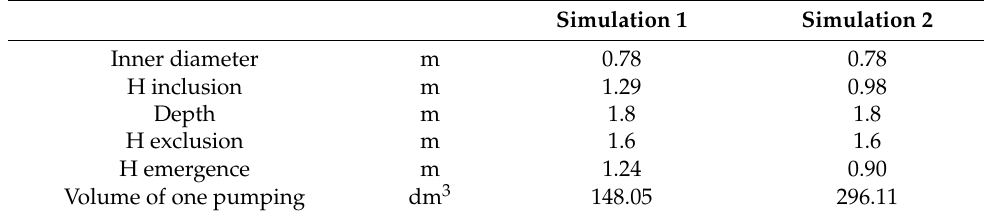
Table 1. The parameters of model pumping stations.